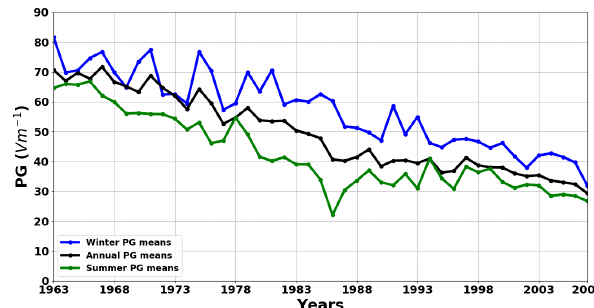
Figure 7. Long-term (1963–2007) PG winter, annual, and summer means measured at NCK.